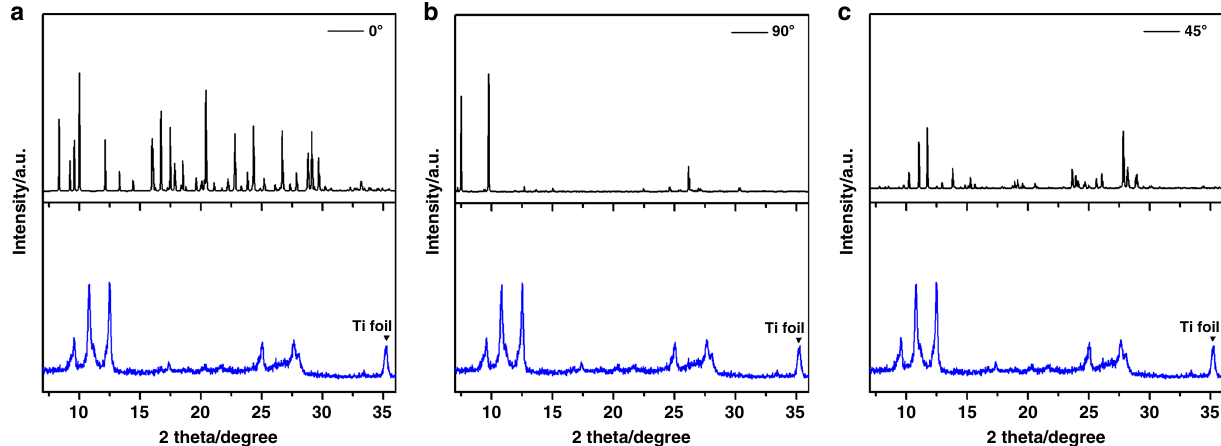
Fig. 7 Simulated XRD patterns of vertically inserted models: a 0°; b 90°; c 45°. Angles are indicating relative slope to PTCDA domains